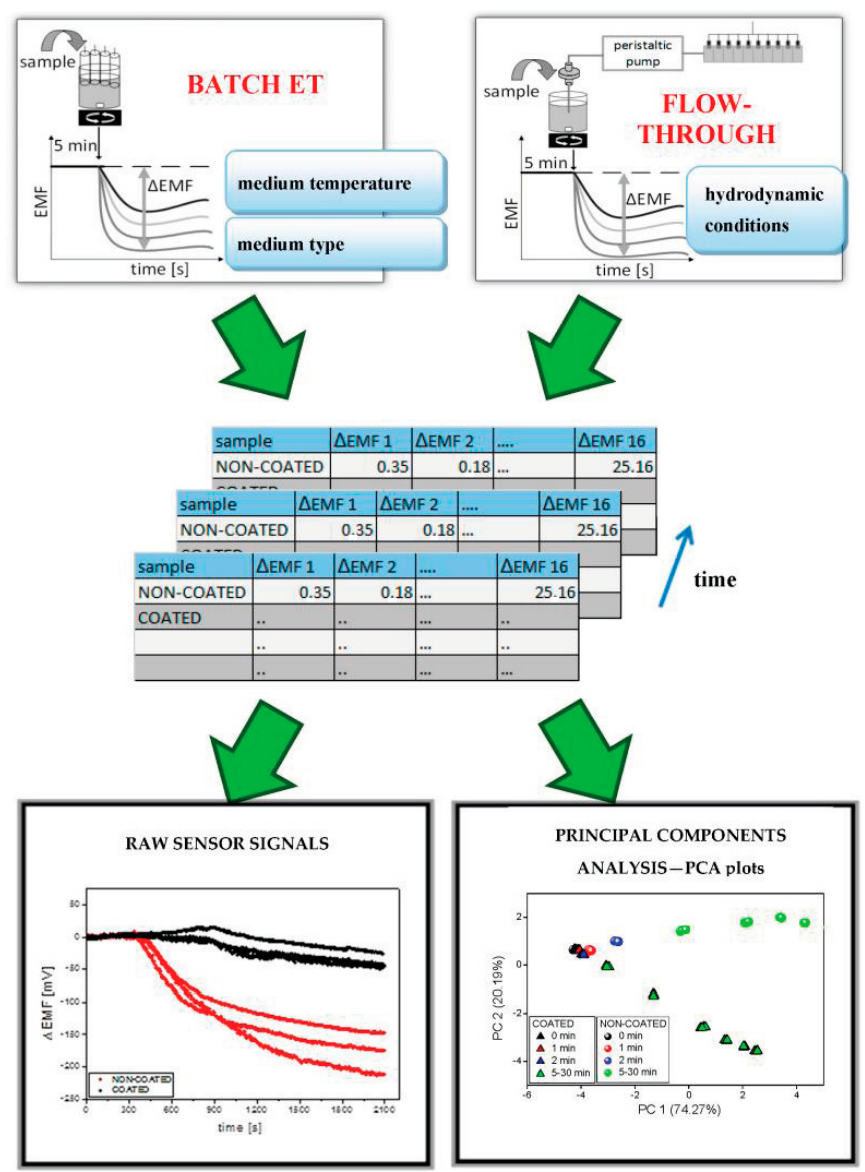
Figure 1. Acquisition and analysis of ET signals.